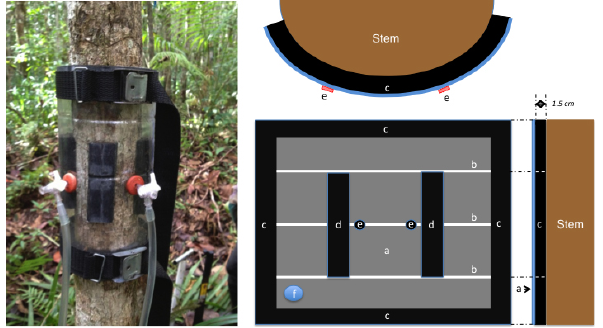
Figure 1. Smaller semi-rigid stem sleeve attached to a stem. The plastic PET sheet (a) has three imprinted circular rims (b) that en- sured good stability and natural curvature of the sleeve. The circum- ference of the sheet was framed with a 1.5cm thick and 3cm wide expanded Neoprene strip (c) that sealed off the headspace located between the sheet and the stem. Inside this volume there were two vertical wedges (d) that kept the sheet at equidistance from the stem along the radial periphery of the sleeve. In its centre the sleeve was equipped with two snap-on rubbers with inserted three-way stop- cocks (e) that were further connected to PVC tubes that went from the sleeve to the Ultraportable Greenhouse Gas Analyser. A coiled vent was placed in one corner of the sleeve (f) to regulate the pres- sure. The chamber was tightened to the stem with the help of two straps that perfectly aligned on top of the horizontal strips.